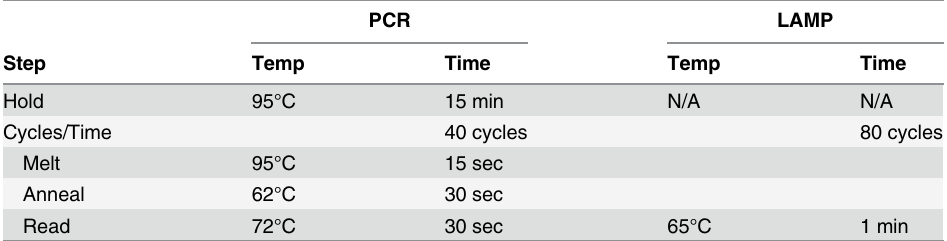
Table 2. Rotor-Gene Q instrument